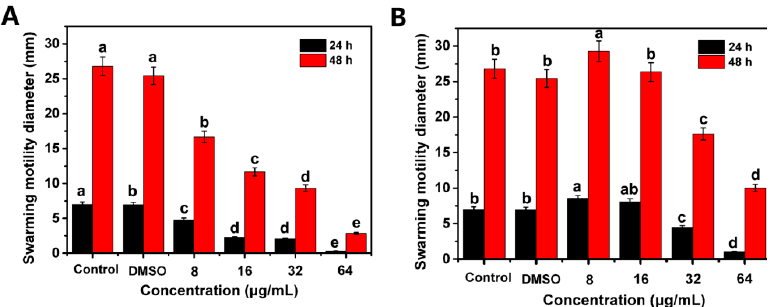
Figure 5. Effects of resveratrol ( A ) and coumarin ( B ) at different concentration on swarming motility of R . solanacearum. Error bars represent the standard deviation ( n =3). Values presented are means and standard errors from four independent experiments. Different letters indicate that the means are significantly different at p = 0.05.